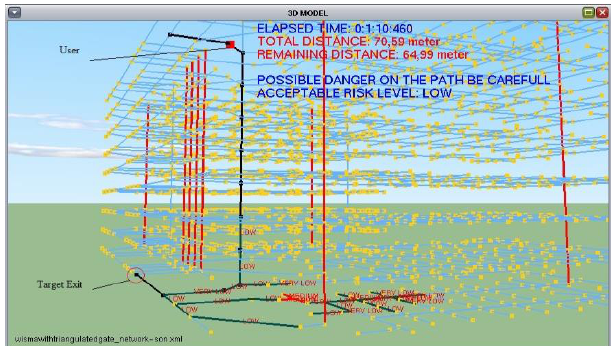
Figure 9. Evacuation scenario